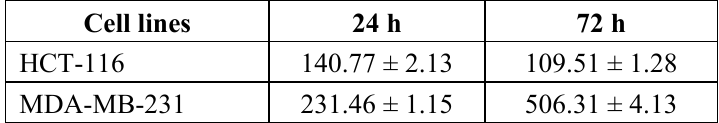
Table 1. Growth inhibitory effects—IC O. vulgare on HCT-116 and MDA-MB-231 cell lines after 24 and 72 h